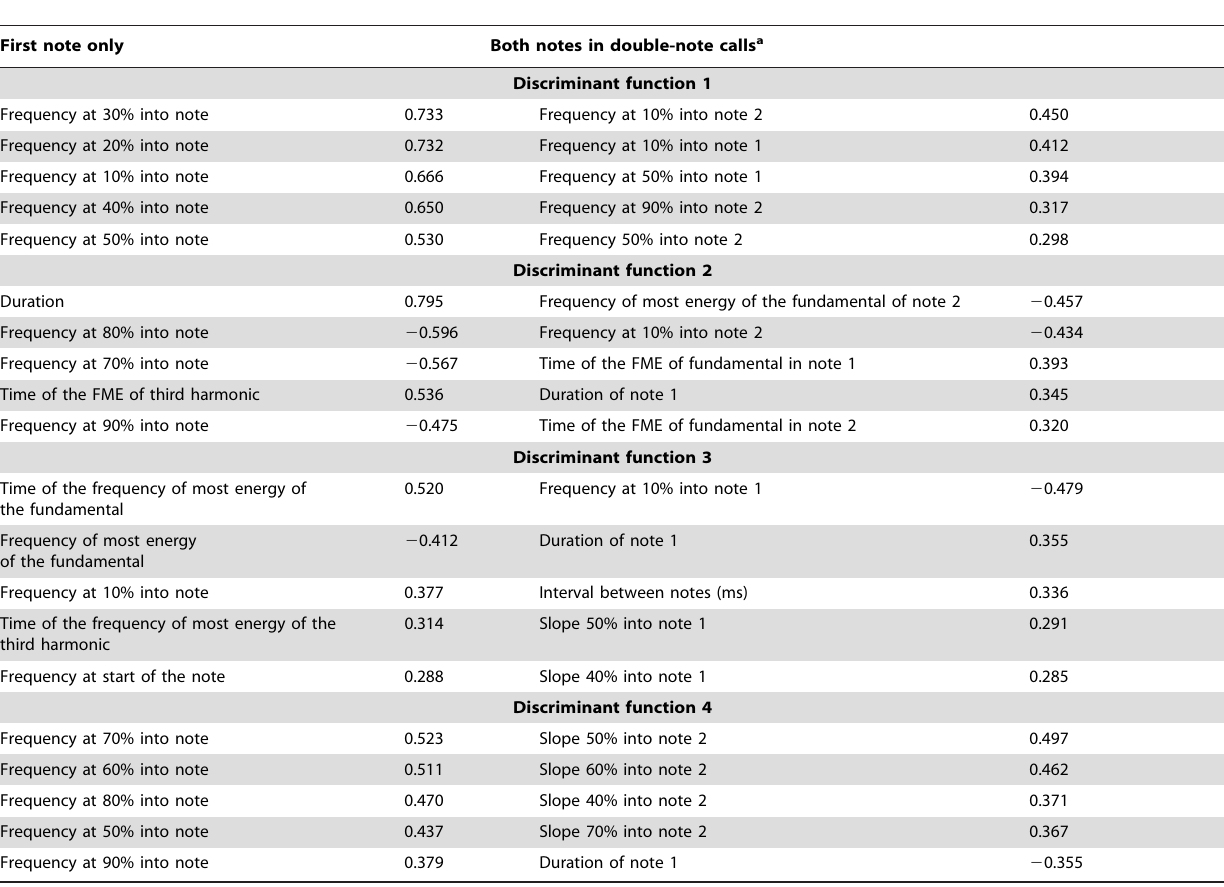
Table 6. Highest variable loadings for discriminant functions assigning notes to individual white-winged vampire